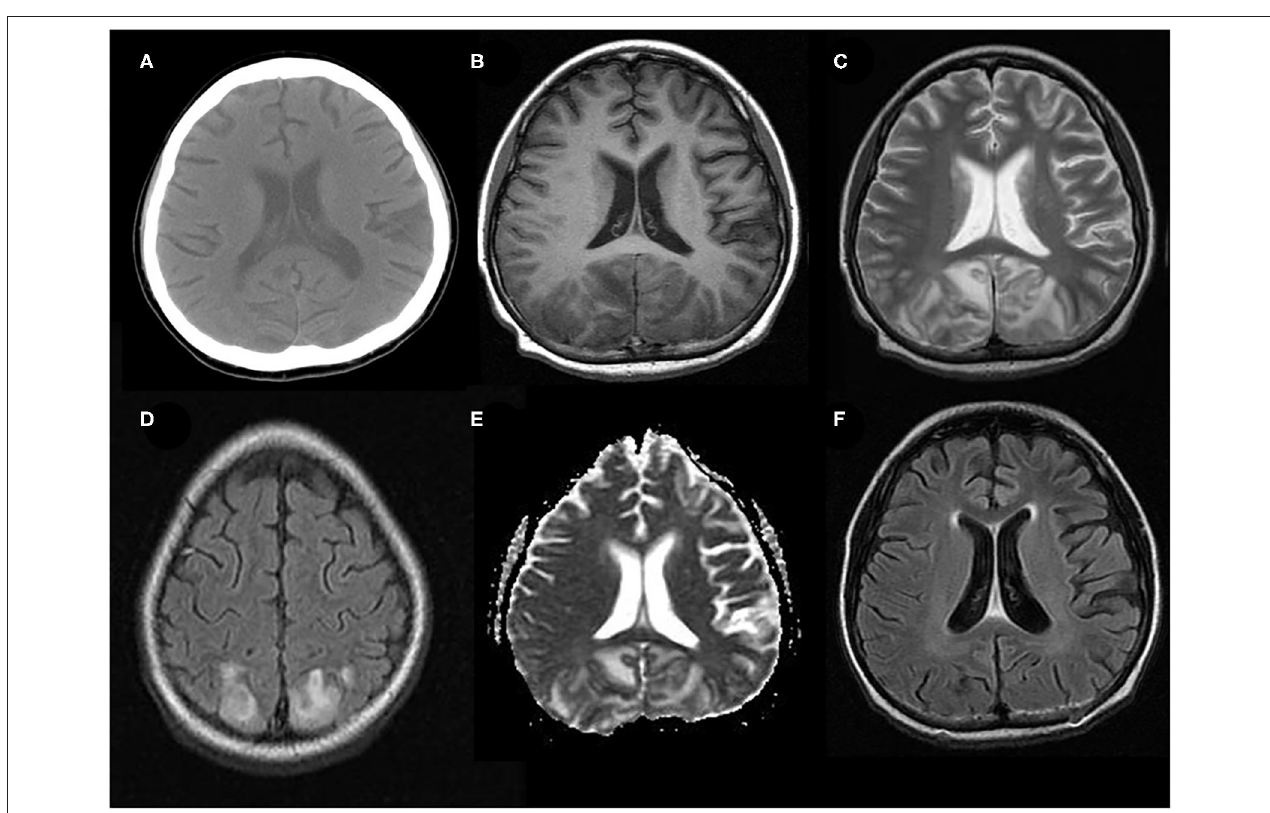
FIGURE 1 | Typical neuroimaging of PRES in a 9-year-old male with underlying nephritic syndrome. (A) Initially, unenhanced brain CT showed mildly cortico-subcortical hypodensities, particularly in bilateral parieto-occipital regions. (B) At the acute stage, these cerebral lesions showed hypointensities on T1-weighted MRI in bilateral parieto-occipital regions (C) T2-weighted MRI, and (D) T2-FLAIR MRI showed symmetrical hyperintensities in bilateral parieto-occipital regions. (E) ADC map shows a hyperintense signal in the aforementioned corresponding areas. (F) FLAIR images 2 months later, showing a complete resolution of the abnormal